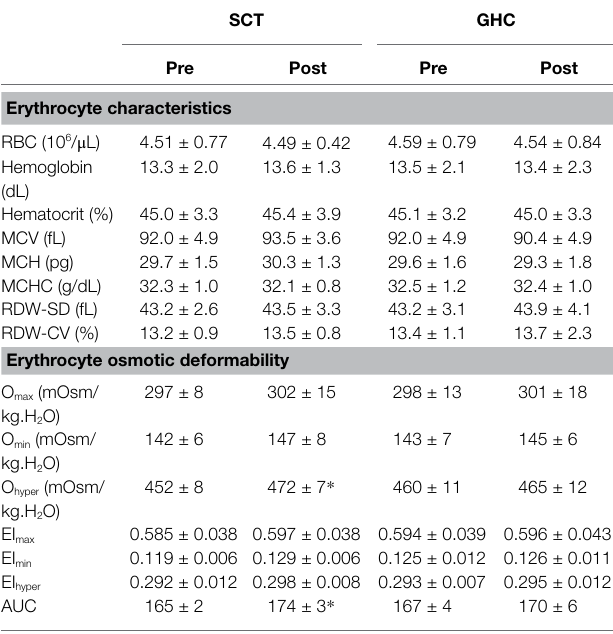
Values are mean ± SD. AUC: area under the individual elongation index-osmolarity curve; EI hyper , EI in osmolality in the hypertonic region corresponding to 50% of the maximal elongation index; EI max , the maximal elongation index; EI min , the minimal elongation index; GHC, general health care; MCV, mean corpuscular volume; MCH, mean corpuscular hemoglobin; MCHC, mean corpuscular hemoglobin concentration; O max , osmolality at EI max ; O min , osmolality at EI min ; O hyper , osmolality in the hypertonic region corresponding to 50% EI max ; Post, after intervention; Pre, before intervention; RBC, red blood cell; RDW-SD or –CV, erythrocyte distribution width-standard deviation or -coefficient of variation; and SCT, supervised cycling